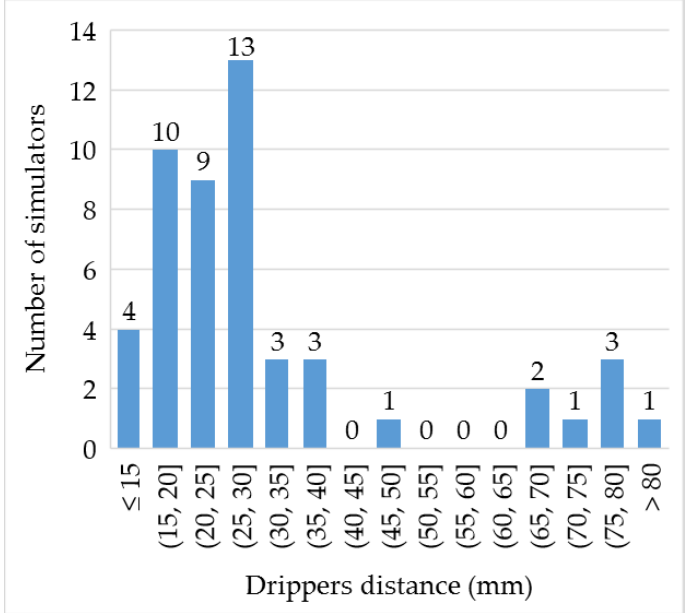
Figure 11. Number of different simulators of a certain value of the mutual spacing of the drippers. Note: the analysis also includes individual simulations with different values of the drippers distance of one simulator.